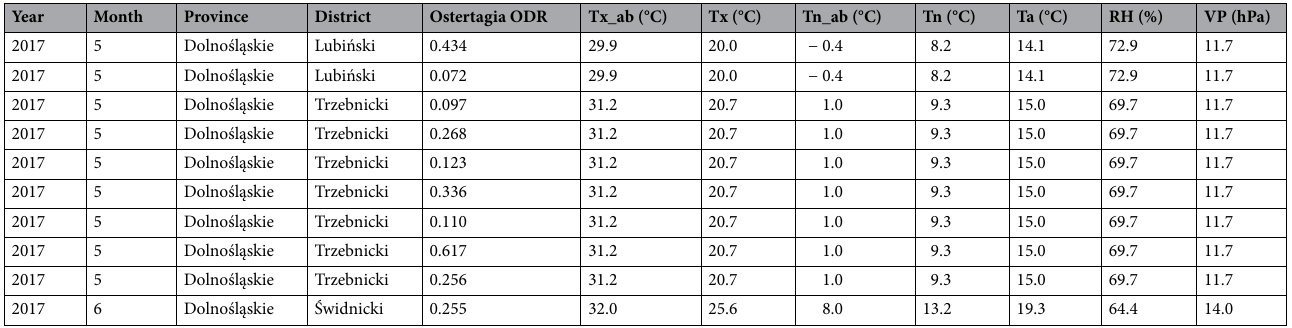
Table 1. An example of the input data inventory.